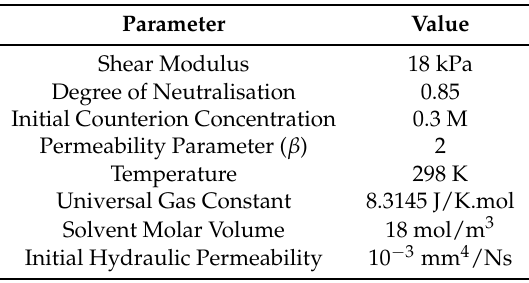
Table 2. List of model parameters, which remain constant throughout each simulation and their associated values. Permeability parameter ( β ) referes to a strain dependent permeability constant [34–36]. The